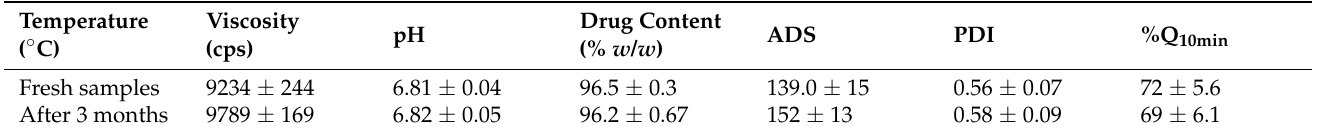
Table 9. Results of stability studies on the optimized formulation after storage for 3 months.